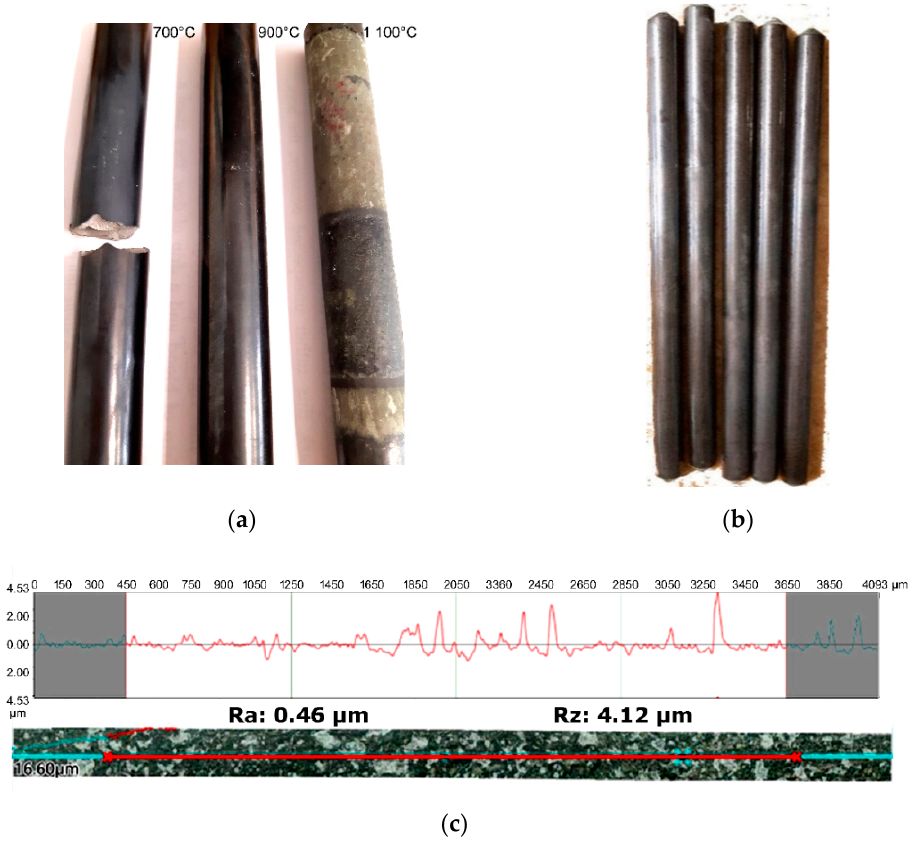
Figure 8. Experimental WNiCo billets swaged at 700 °C, 900 °C, and 1100 °C ( a ); five WNiCo billets swaged at 900 °C ( b ); surface scan of billet swaged at 900 °C (acquired by KEYENCE VHX7000) ( c ).